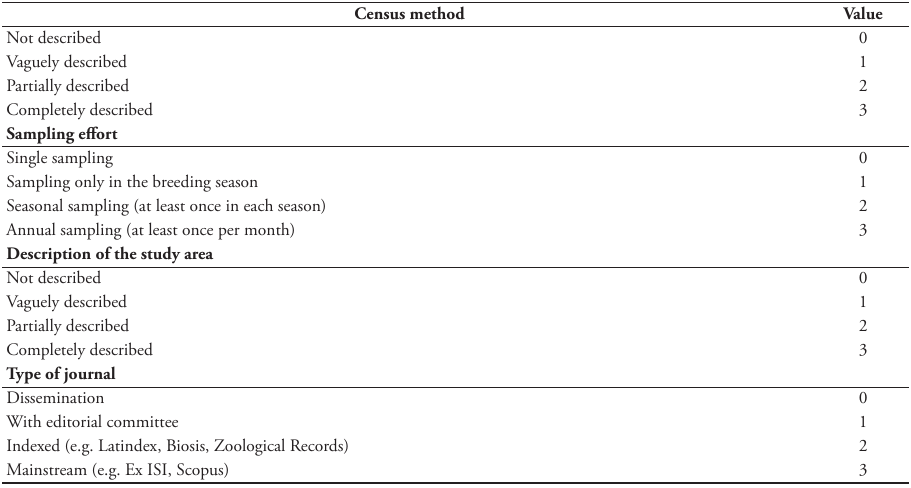
Table 1. Factors used to assign Eligibility Value (EV) to the articles